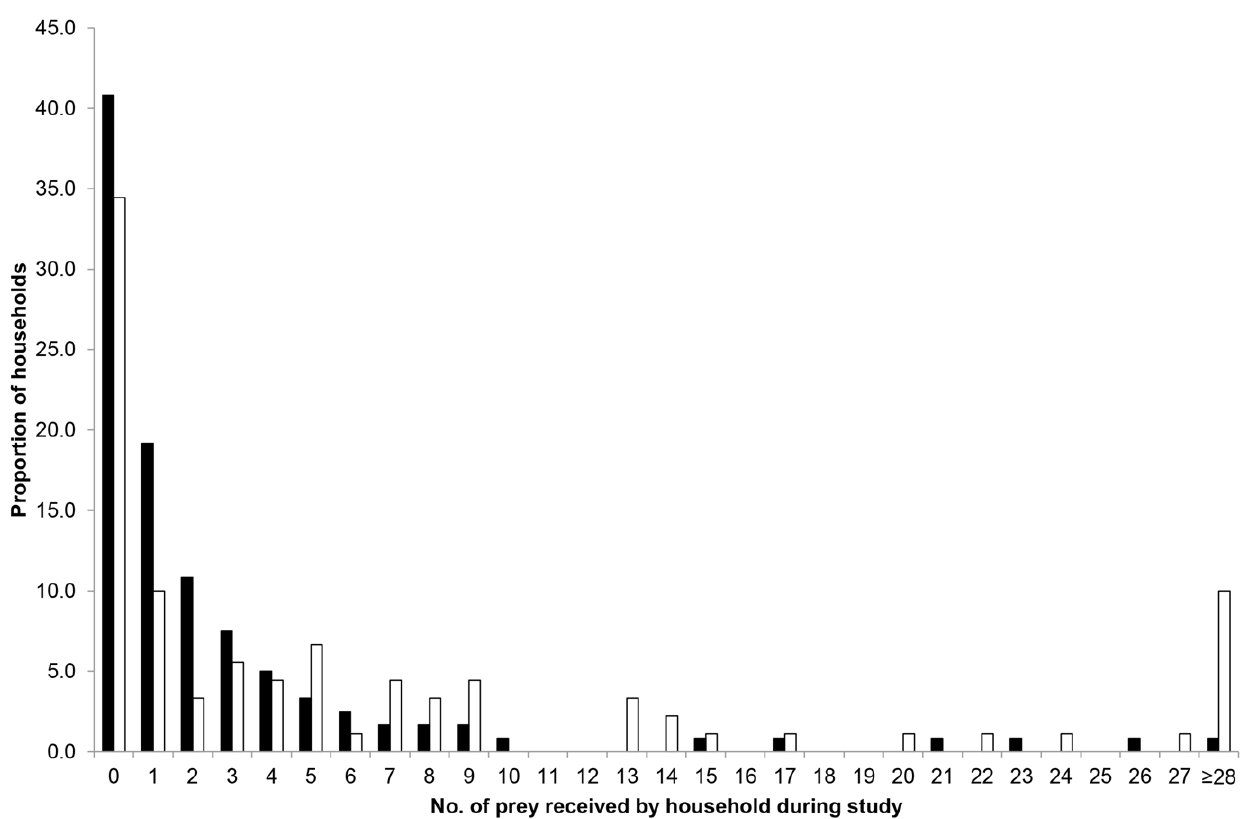
Figure 1. Frequency of number of prey returned in single-cat (black bars) and multiple-cat (white bars) households.